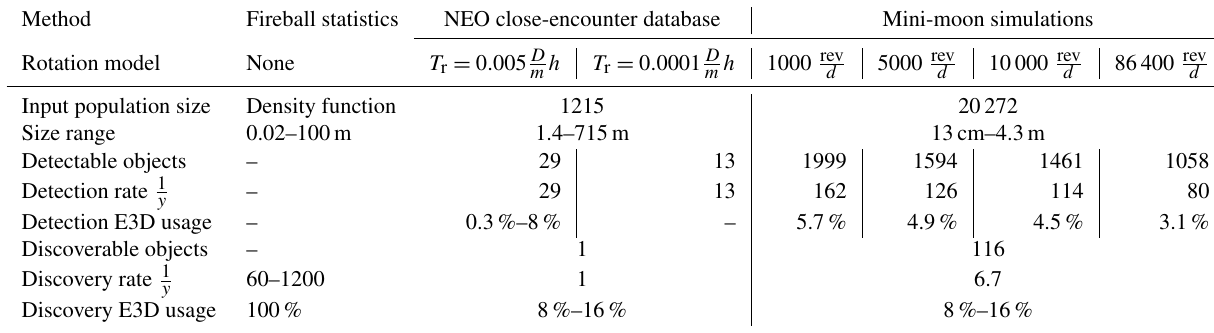
Table 3. Summary statistics from all three methods used to determine the observability of NEOs with